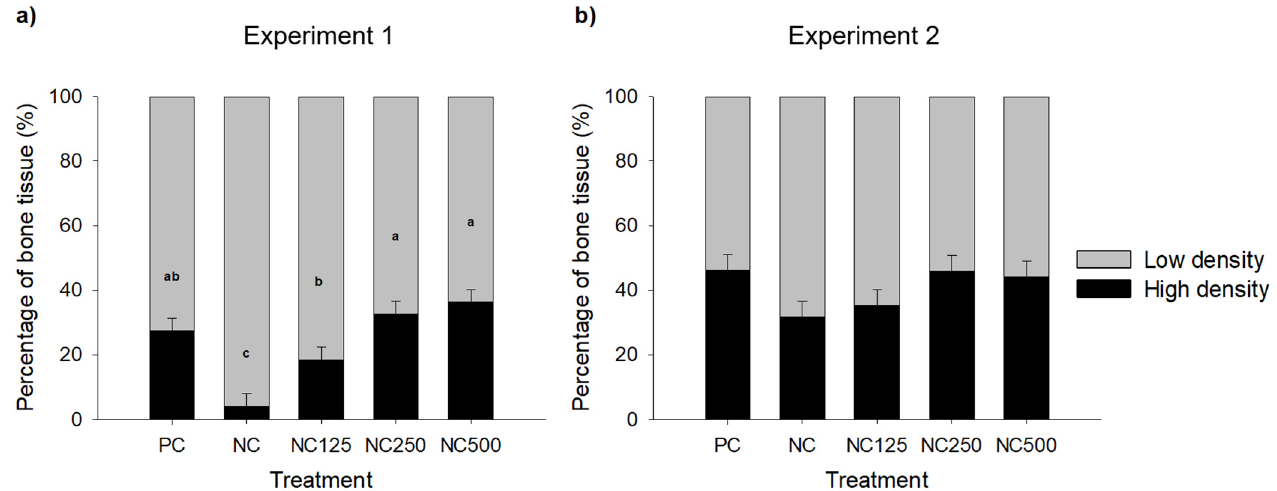
Figure 2. Proportion of low-density (HU values ranging from 141–500) and high-density (HU values above 500) tissues with respect to total bone (HU > 140) in left Os metacarpale IV bone of piglets as measured by computed tomography in ( a ) Experiment 1 and ( b ) Experiment 2. NC = negative control; NC125 = NC diet with phytase at 125 FTU/kg feed; NC250 = NC diet with phytase at 250 FTU/kg feed; NC500 = NC diet with phytase at 500 FTU/kg feed. Values in the table are LSMEANS of one animal per pen (8 pens per treatment) for each experiment. Bars with different letters differ significantly at p < 0.05 (LSD test). Significant linear and quadratic responses to phytase dose addition to the NC diet were observed in Experiment 1 ( p < 0.001 and p = 0.016, respectively).